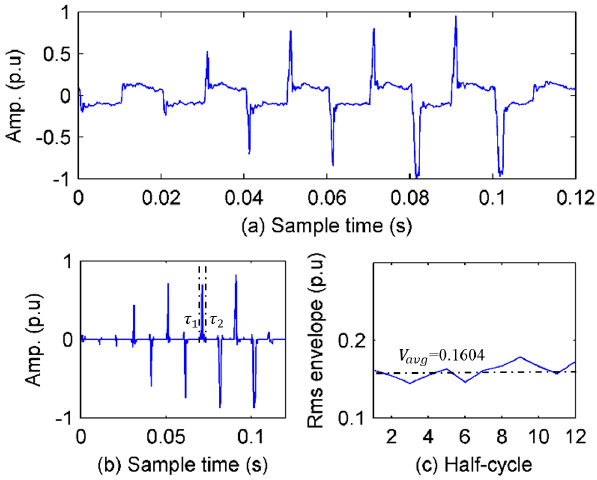
Figure 5. Parameter preparation of arc voltage from the IEEE PES database; ( a ) Real arc signal; ( b ) Recovery of extracted impulse; ( c ) RMS envelope of fundamental.